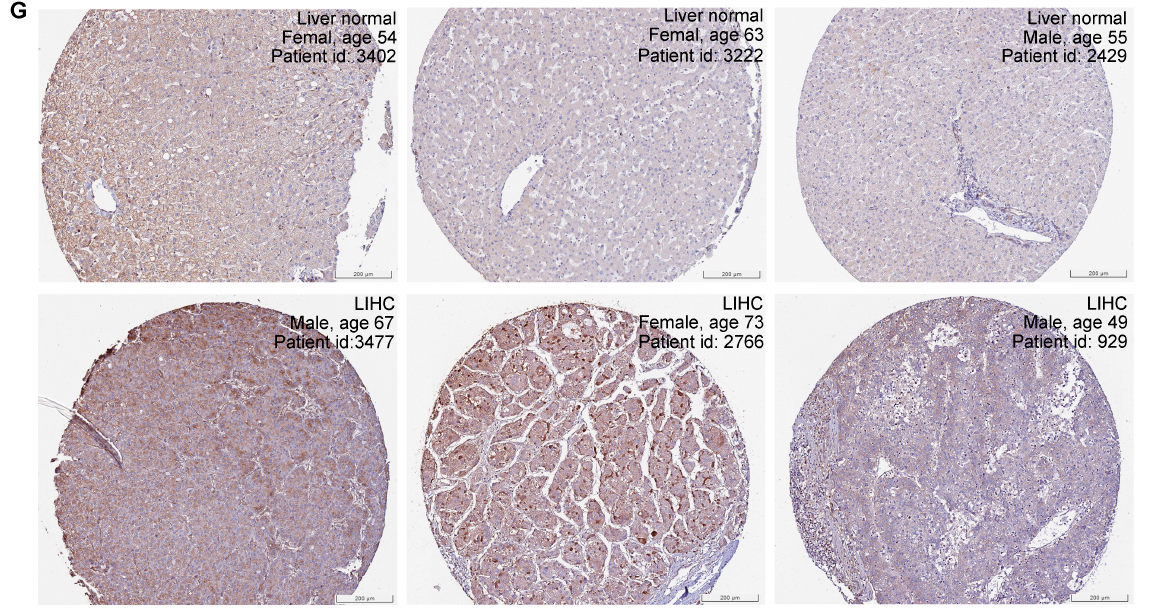
Figure 1. Differential expression of TUBA1B in normal and HCC tissues. ( A ) TUBA1B expression in 33 types of cancers in TIMER. ( B ) TUBA1B expression levels in 1010 LIHC cohorts in HCCDB. ( C ) Different TUBA1B expression in normal and LIHC tissues in GEPIA. ( D ) Different TUBA1B expression in LIHC and normal tissues in TCGA. ( E , F ) Different TUBA1B expression in LIHC and normal tissues in GEO. ( G ) IHC staining of TUBA1B in liver normal tissues (above) and LIHC tissues (below). * p < 0.05, ** p < 0.01, *** p < 0.0001, **** p <